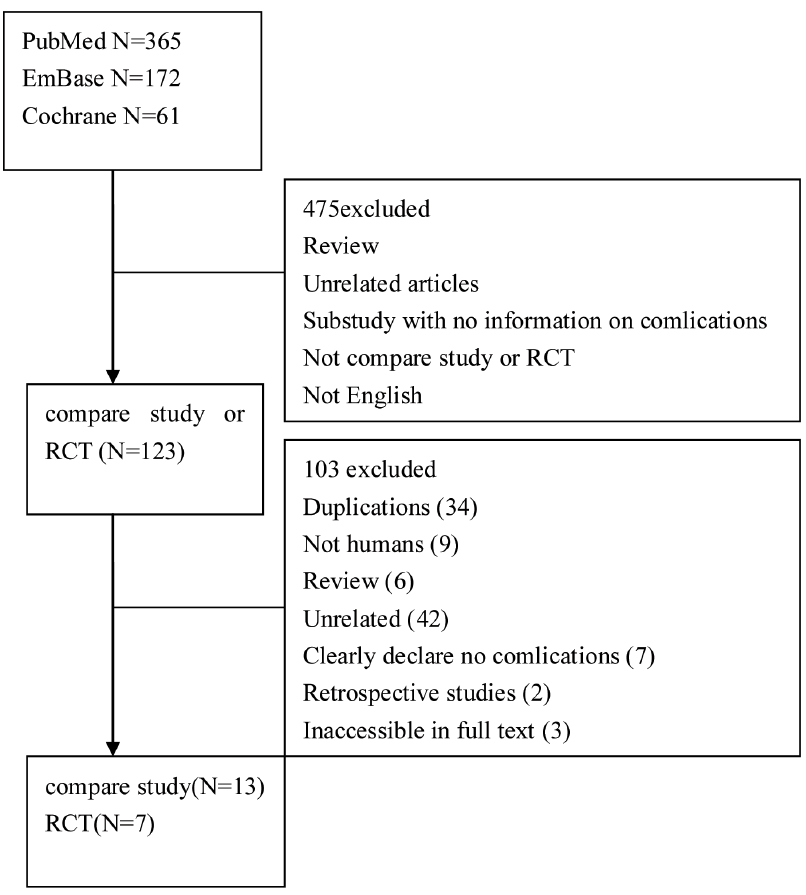
Figure 1. Study flow diagram.